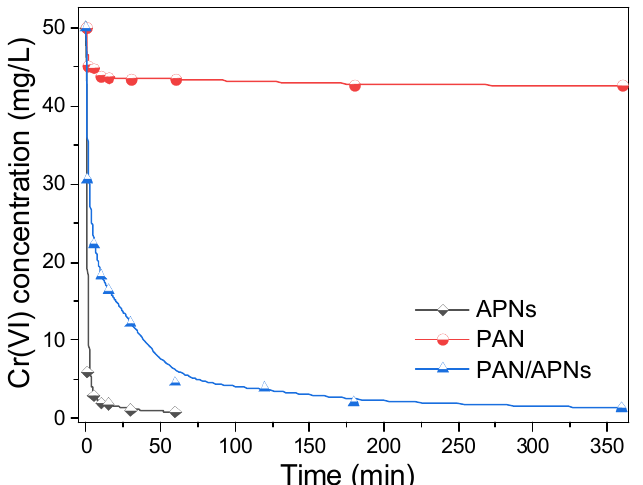
Figure 3. Adsorption rate of Cr(VI) by APNs, PAN/APNs and PAN (C 0 = 50 mg/L; adsorbent dose = 0.5 g/L; T = 298 K; pH = 2).